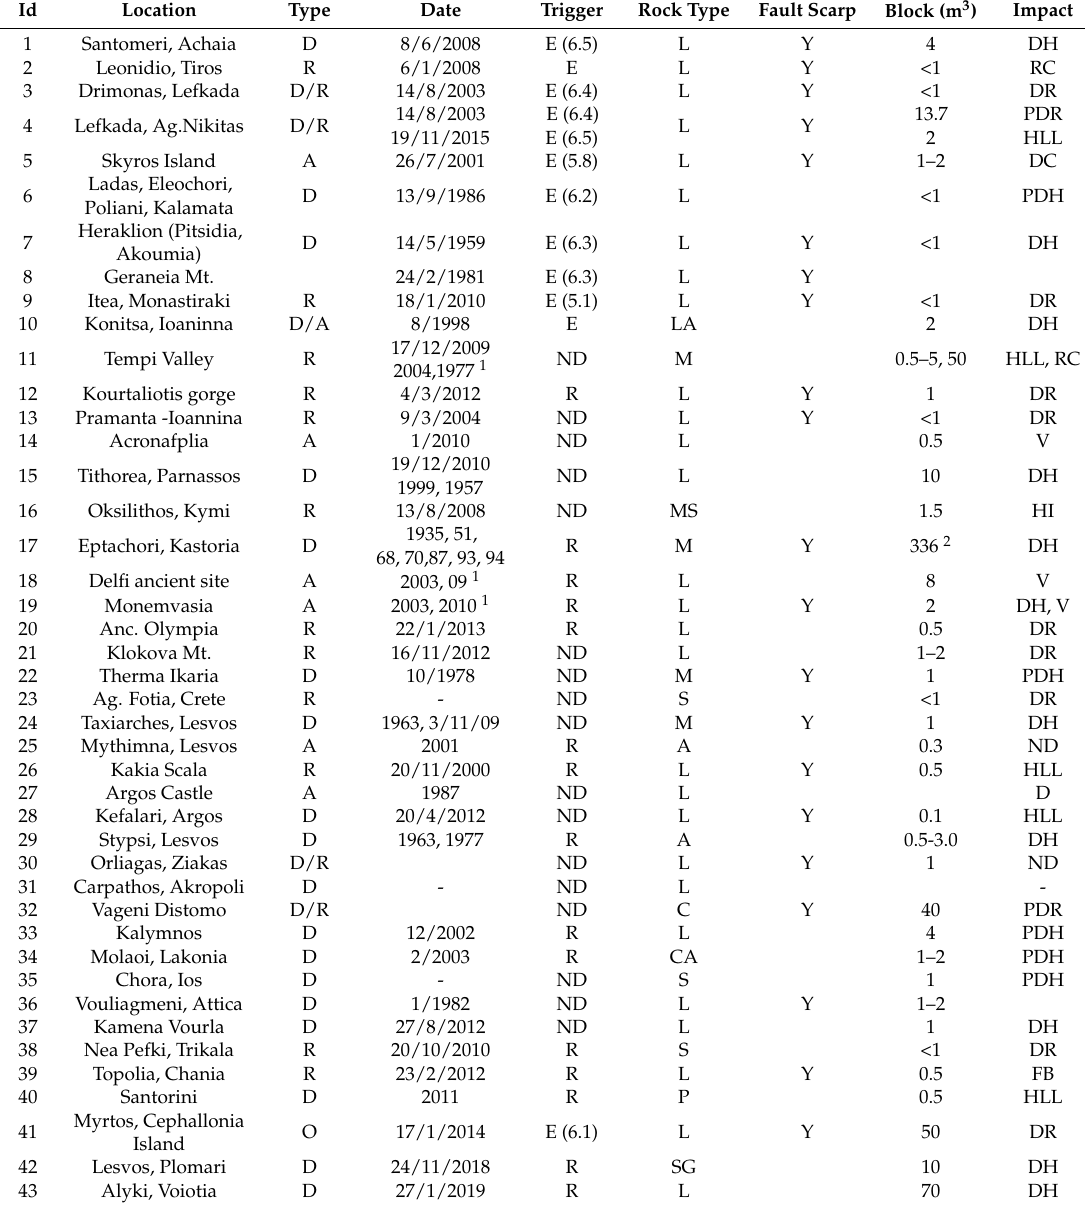
Table 1. Main data of recorded rockfalls in